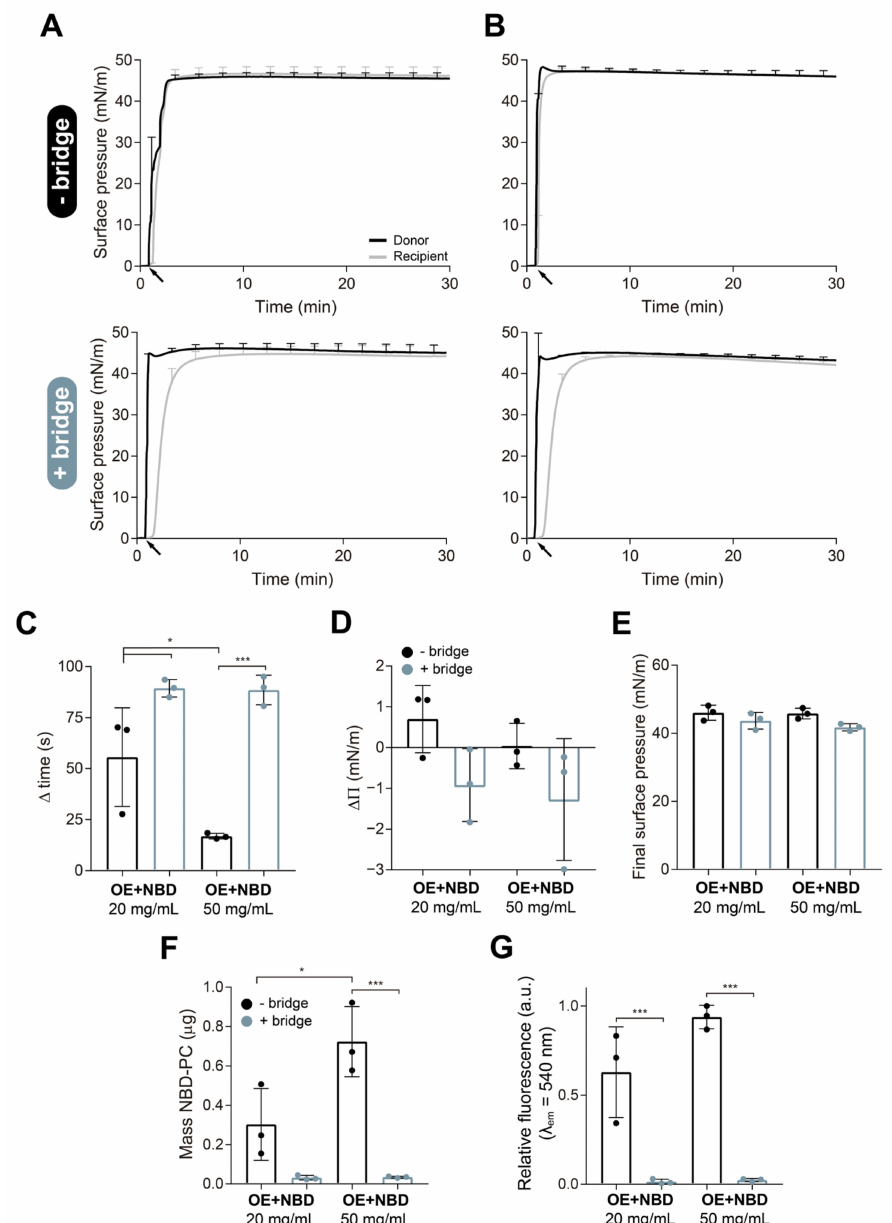
Figure 2. Analysis of the effect of surfactant concentration on interfacial spreading. Adsorp- tion/spreading isotherms derived from the interfacial injection of 15 µ L of an aqueous suspension of organic extract from native surfactant (OE) labelled with 1% (mol/mol) NBD-PC, at ( A ) 20 mg/mL or ( B ) 50 mg/mL, at the donor compartment of the vehiculization double-balance design. Experiments at both concentrations were performed in the absence (upper panels) and in the presence (bottom panels) of the paper bridge. Surface pressure was monitored for 30 min at the donor (black line) and recipient (grey line) compartments. Black arrows indicate material injection onto the donor interface. ( C ) Delay in the increase in surface pressure at the recipient compartment, measured as the time difference in seconds between the injection of the material onto the donor interface and the pressure increase in the recipient compartment until it reaches the half maximal pressure ( Π 50 ). The delay has been compared as obtained in experiments with (blue bars) and without (black bars) the bridge, and at both OE concentrations. ( D ) Difference in surface pressure between recipient and donor compartments ( ∆Π ) registered 30 min after sample injection. Negative results mean that